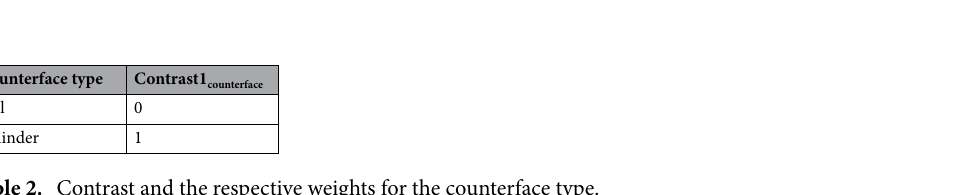
Table 2. Contrast and the respective weights for the counterface